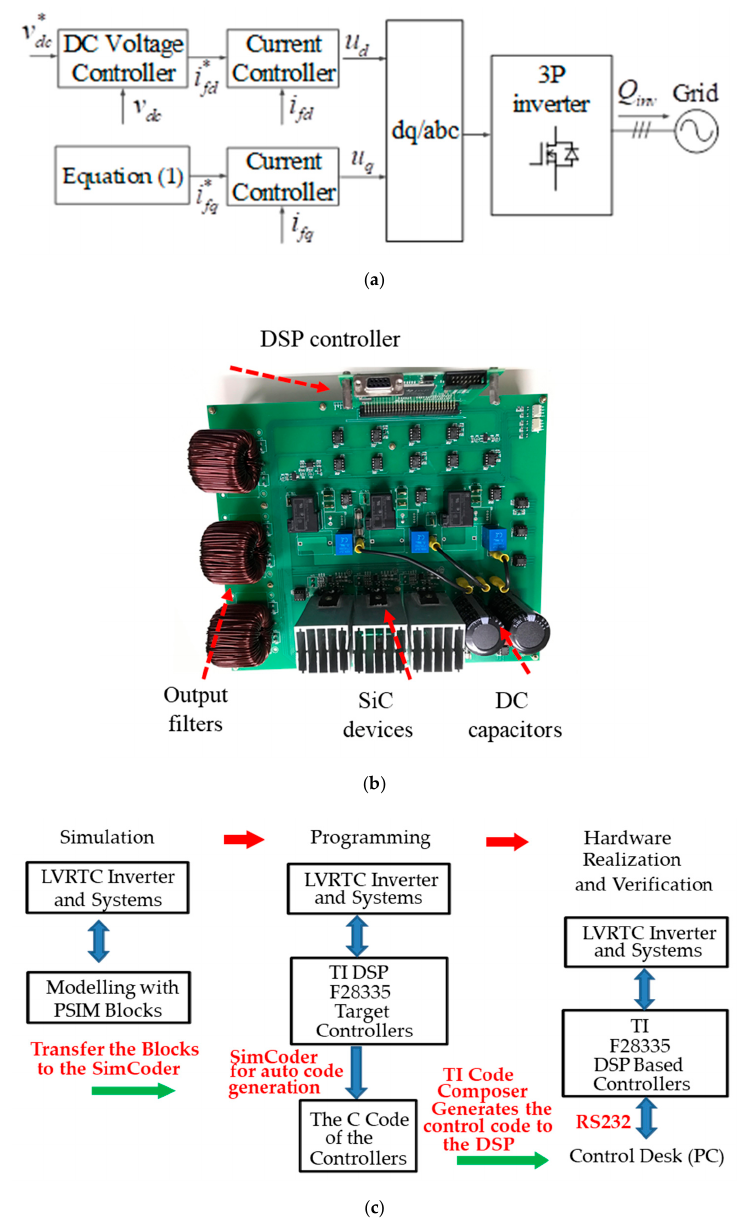
Figure 9. ( a ) Schematic of simulated grid-connected LVRTC; ( b ) the photograph of the LVRTC SiC-based 3P inverter circuit prototype; ( c ) the DSP programming steps in hardware implementation of LVRTC.